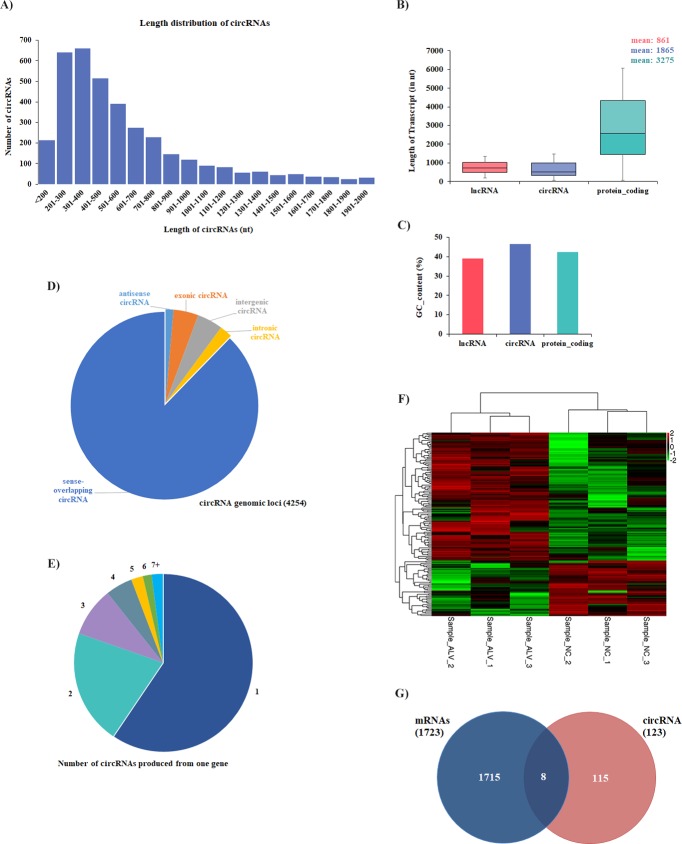
Profiling of circRNAs in chicken normal and ALV-J-infected tissues.(A) Length distribution of circRNAs. (B) Transcript length comparison, chicken circRNAs was about one-second of the length of protein-coding transcripts, and twice the length of lncRNAs (mean length of 861 nt for lncRNAs; 1865 nt for circRNAs; 3275 nt for protein-coding transcripts). (C) GC content, lncRNA shows in red, circRNA in purple and protein-coding transcripts in green, the average GC content of three kinds of transcripts were almost equal (mean GC content of 46% for circRNAs; 40% for lncRNAs; 42% for protein-coding transcripts). (D) Genomic origin of chicken circRNAs. (E) Number of circRNAs produced form one gene in chicken (4,254 circRNAs from 2,191 host genes). (F) Heatmaps of 152 significantly differentially expressed circRNAs show normalized expression values. Columns represent samples, and rows represent transcripts. Colors are used to represent expression levels: above (red) or below (green) (expression data was normalized from -2 to +2). Sample_ALV: ALV-J infected tissues; Sample_NC: normal uninfected tissues. (G) Venn diagrams of differentially expressed mRNAs, circRNA host genes.